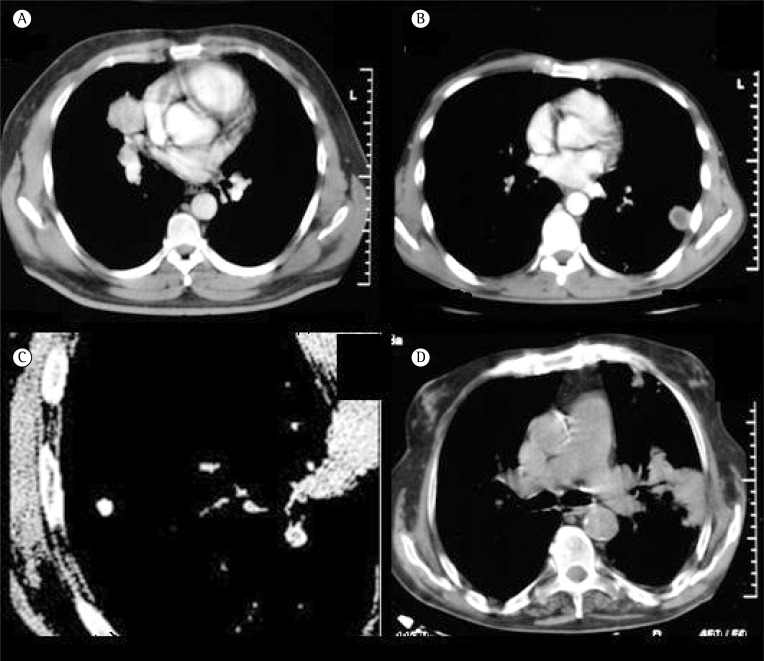
Cortes de TC helicoidal mostrando alterações intralesionais com aspecto
homogêneo (em A; paciente masculino, 49 anos), necrose (em B; paciente
masculino, 36 anos), calcificação (em C; paciente masculino, 56 anos) e
broncograma aéreo (em D; paciente masculino, 77 anos).